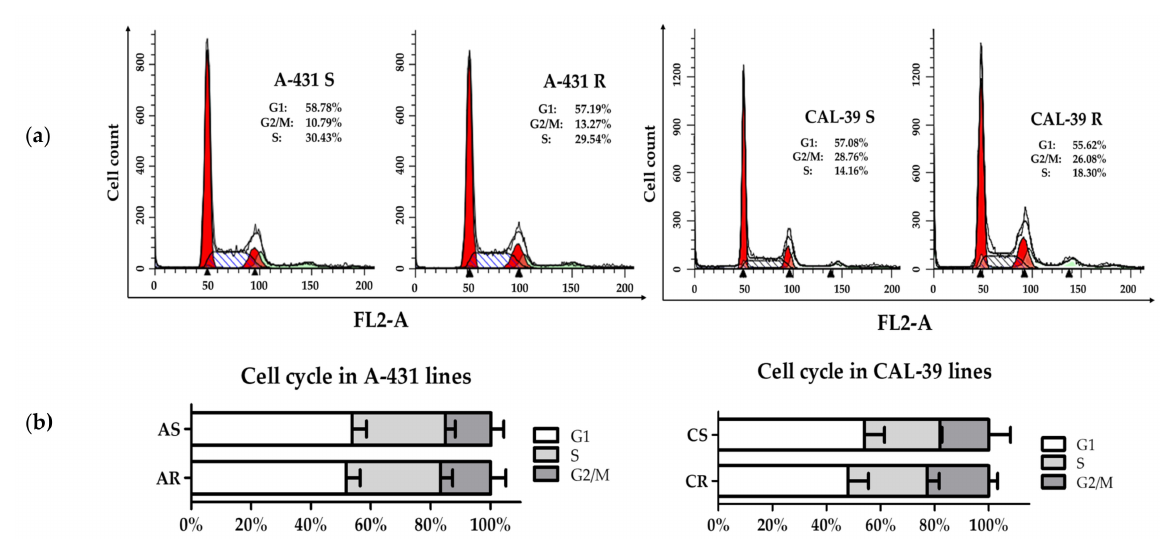
Figure 3. Cell cycle analysis. ( a ) Histograms of DNA content in cell. ( b ) Graphs of the percentage of cells in the G1, S, G2/M cycle phases.